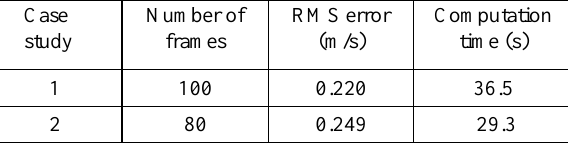
Table 2. Parameters for the two case studies.